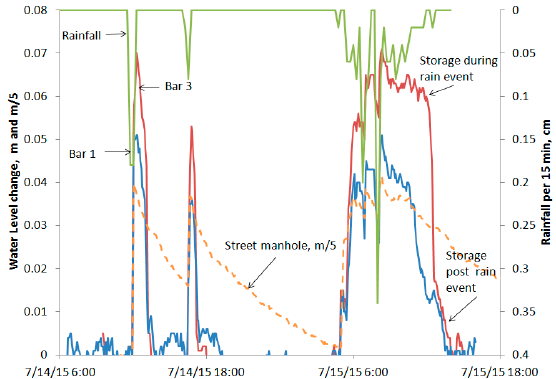
Figure 4. Water level responses on two blue roofs (Bar 1 and Bar 3) and a street manhole. The street